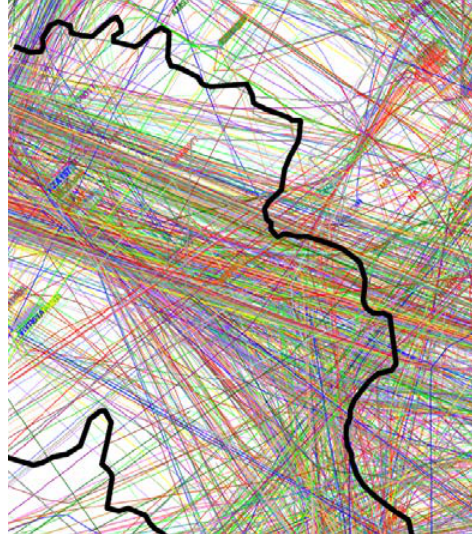
Figure 3. Real flown trajectories above 24 500 ft, on March 24, 2010, above the flight area for